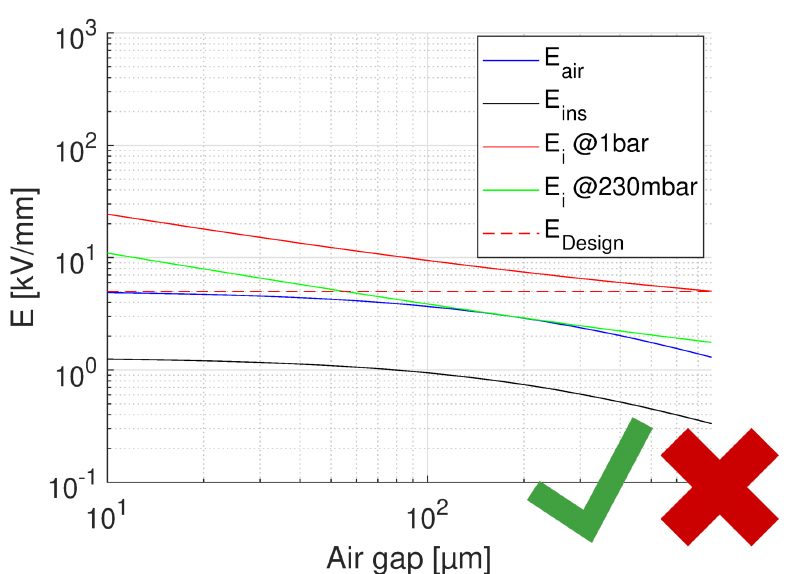
Figure 13. Feasibility plot for the design of slot insulation, with the insulation thickness (H2 = 770 µ m) providing no PD for any air gap and considered pressure range. Voltage = 1000 V (Figure 2, Table 1). The x axis reports the air gap